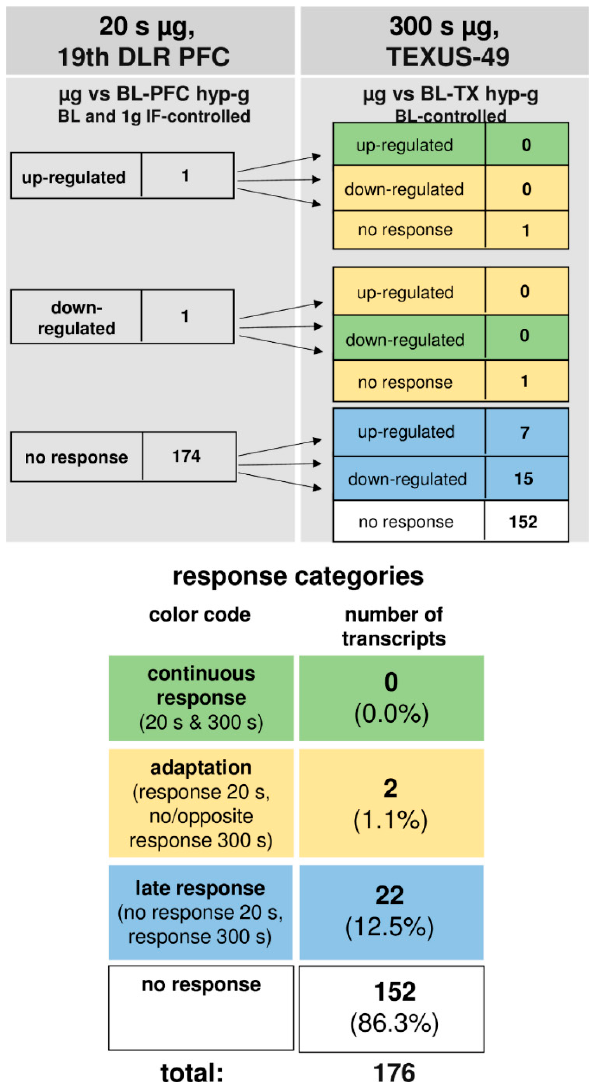
Figure 5. Time course of differential expression of 188 transcripts in microgravity (list of genes in